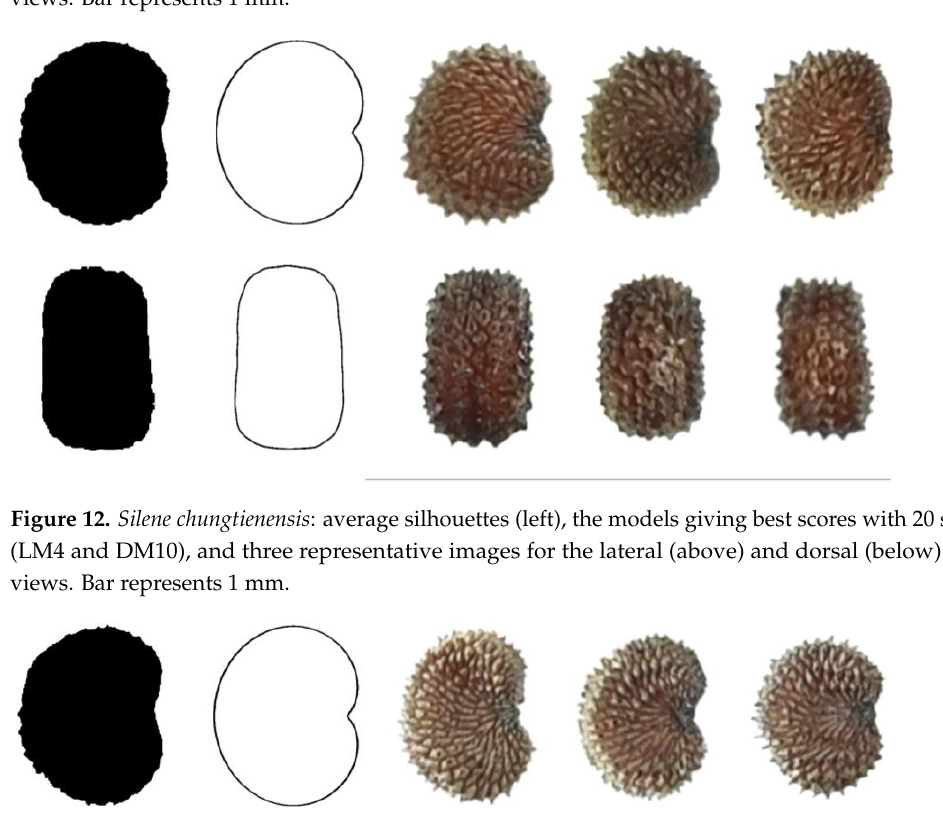
(LM4 and DM5), and three representative images for the lateral (above) and dorsal (below) seed